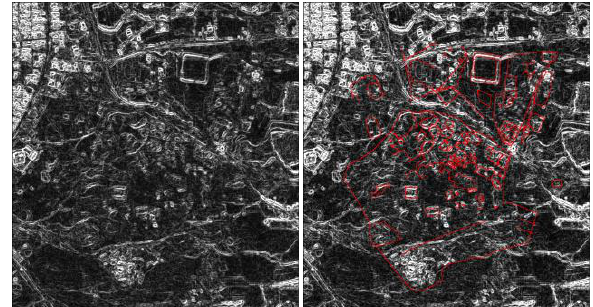
Figure 14a, b – A high pass 9x9 filter used on FORMOSAT-2 image of Makhmúr al-Qadima site with overlaid objects of interest on the left picture